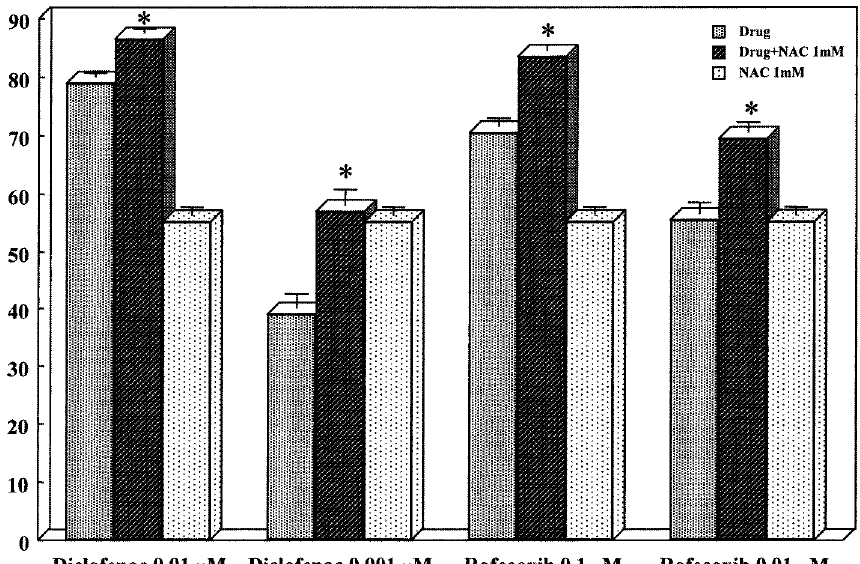
FIG. 1. The effect of 1 mM NAC on the diclofenac-induced and rofecoxib-induced inhibition of PGE 2 formation in activated monocytes. * p < 0.05 for % inhibition (NSAID + NAC) versus % inhibition (NSAID), Wilcoxon paired test. All data shown are mean ± SEM of number of observations ( n ). Number of observations: 0.01µM diclofenac, n = 9; 0.001µM diclofenac, n = 6; 0.1µM rofecoxib and 0.01µM rofecoxib, n =